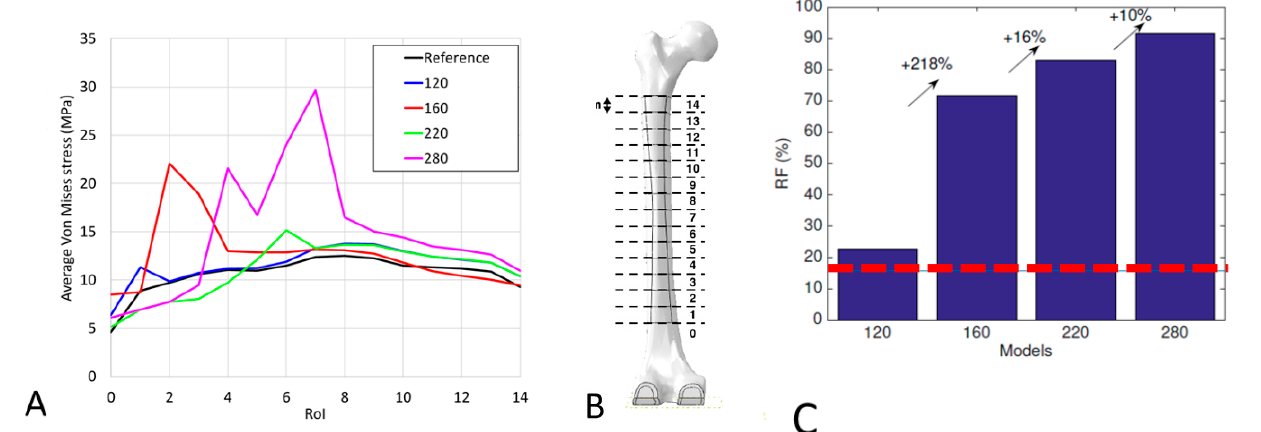
Figure 4. Average von Mises stress for the reference model and for different lengths of straight stem configurations: ( A ) Behavior of the stress in the regions of interest considered for the different con- figurations; ( B ) Regions of interest analyzed; ( C ) Risk of fracture calculated for each configuration. The red dotted line in the figure reports the risk of fracture for the reference model. The arrows represent the increment in Risk of Fracture compared to the previous configurations.